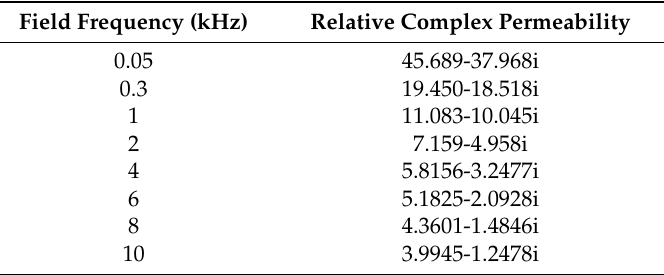
Figure 5. The distribution of magnetic flux density around the particle under different field frequencies. ( a ) The distribution of magnetic flux density along the x axis; ( b ) The distribution of magnetic flux density along the y or z axis. Table 1. The relative complex permeability of material under different field frequencies. Field Frequency (kHz)